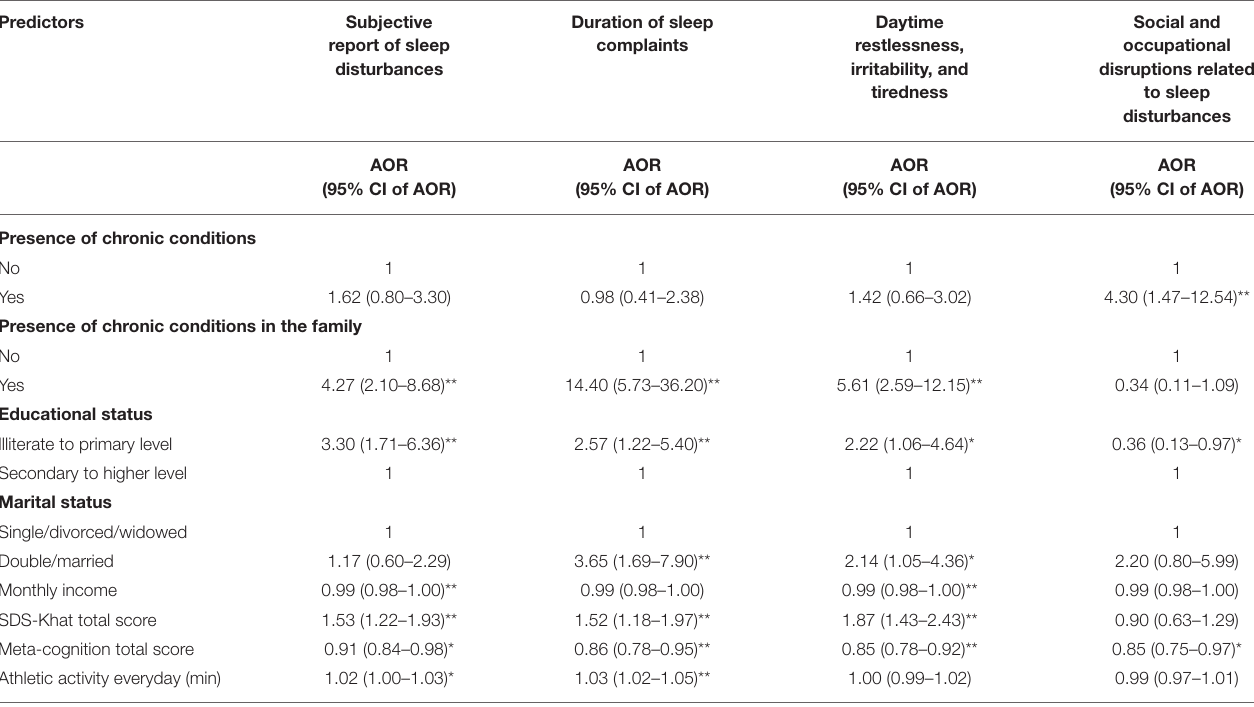
TABLE 3 | Logistic regression predicting poor sleep-related symptoms in polysubstance